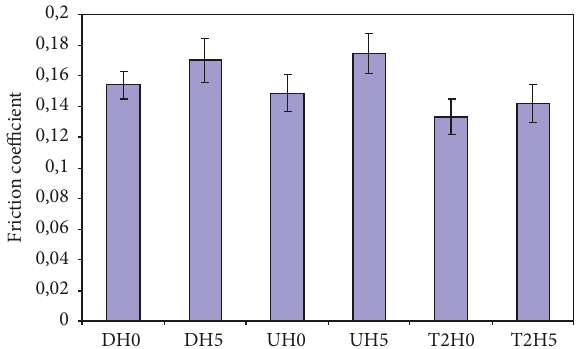
Figure 5: Friction coefficient for POM and POM/HAp nanocom- posites.